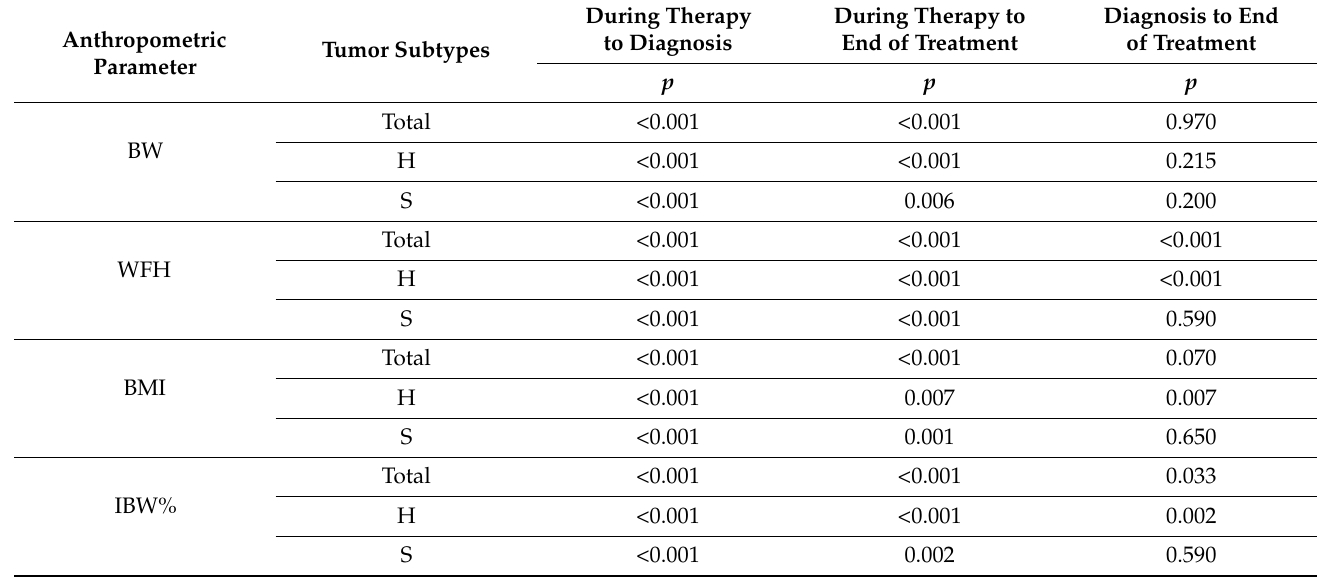
Table 3. Compering mean values of anthropometric data at the three examined